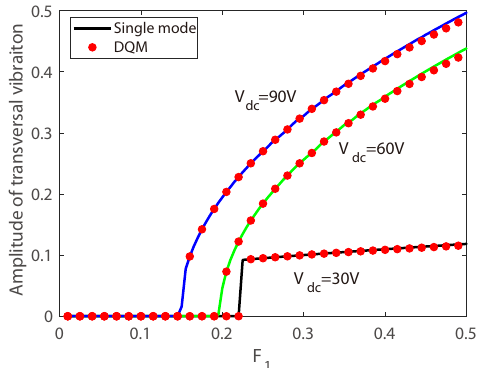
Figure 4. Comparison of the force-amplitude response curves obtained by single mode Galerkin approximation and differential quadrature